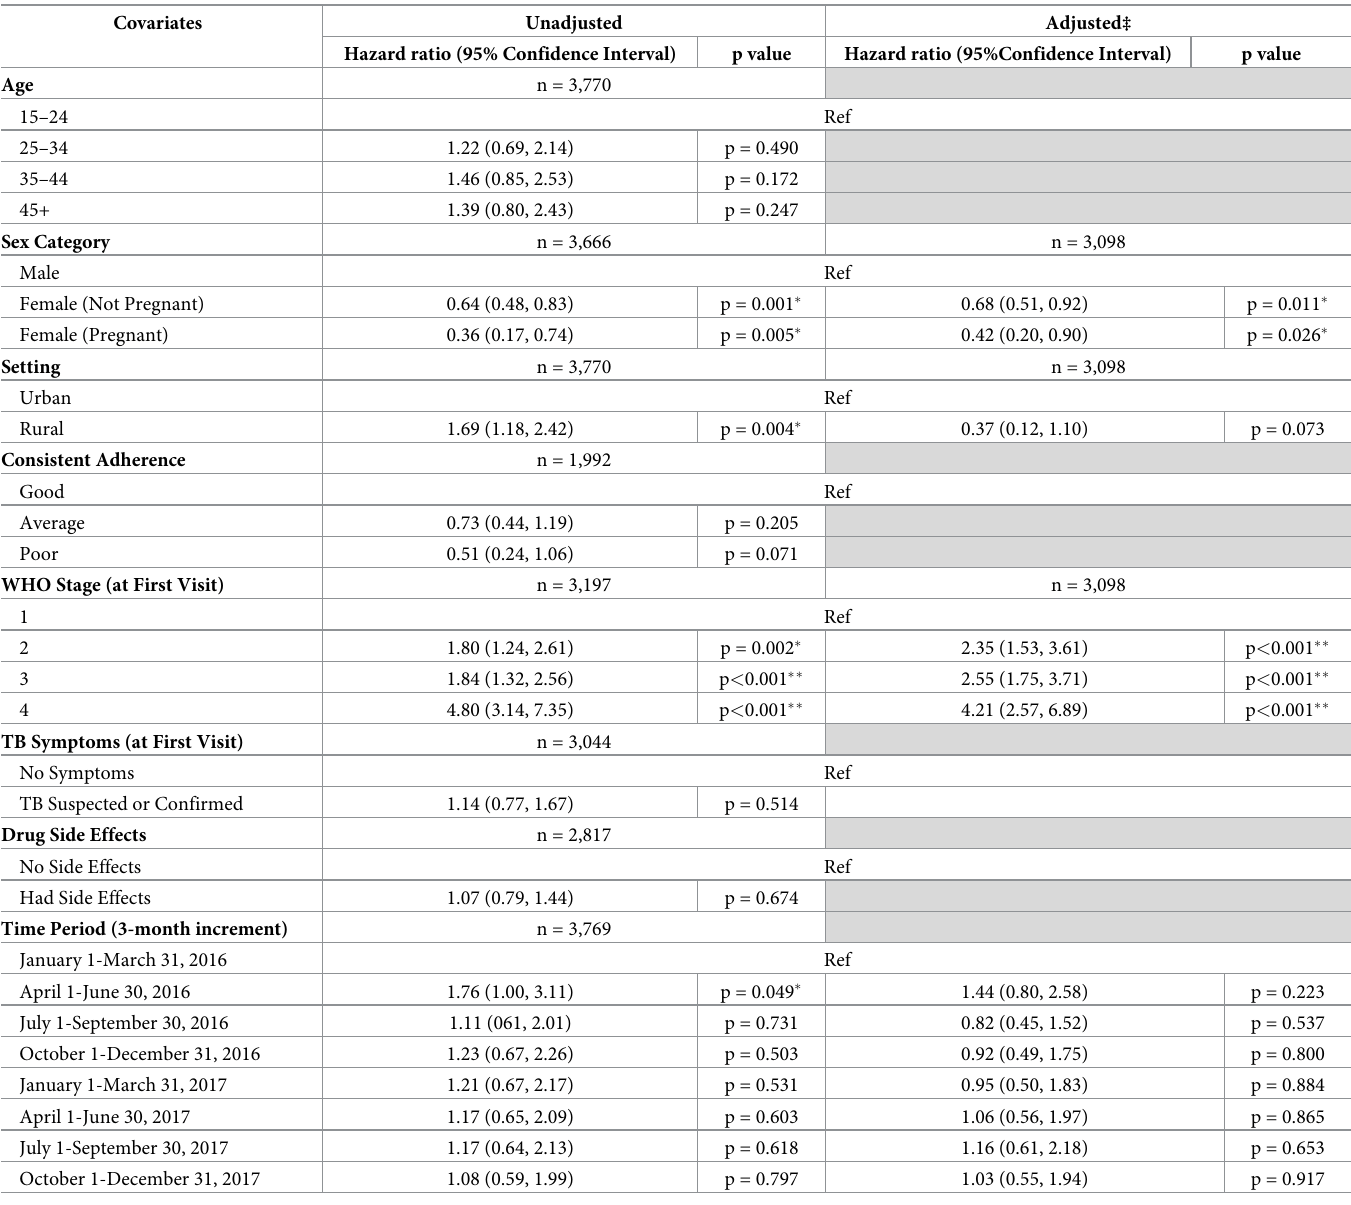
Table 3. Estimates of factors associated with death among adolescents and adults in care and treatment.